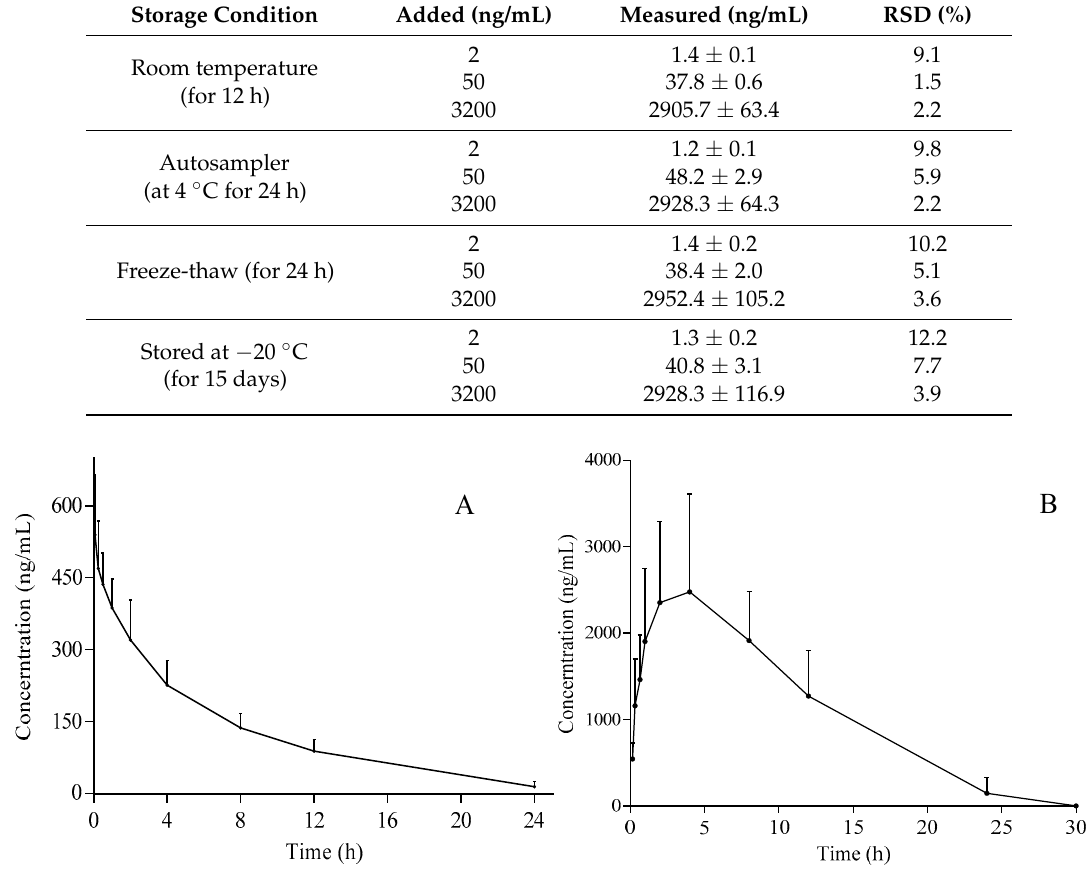
Figure 3. Plasma concentration–time plots of gomisin D after i.v. ( A ) and i.g. ( B ) administration. Table 4. Pharmacokinetic parameters of gomisin D in two groups (mean ± SD, n = 12).